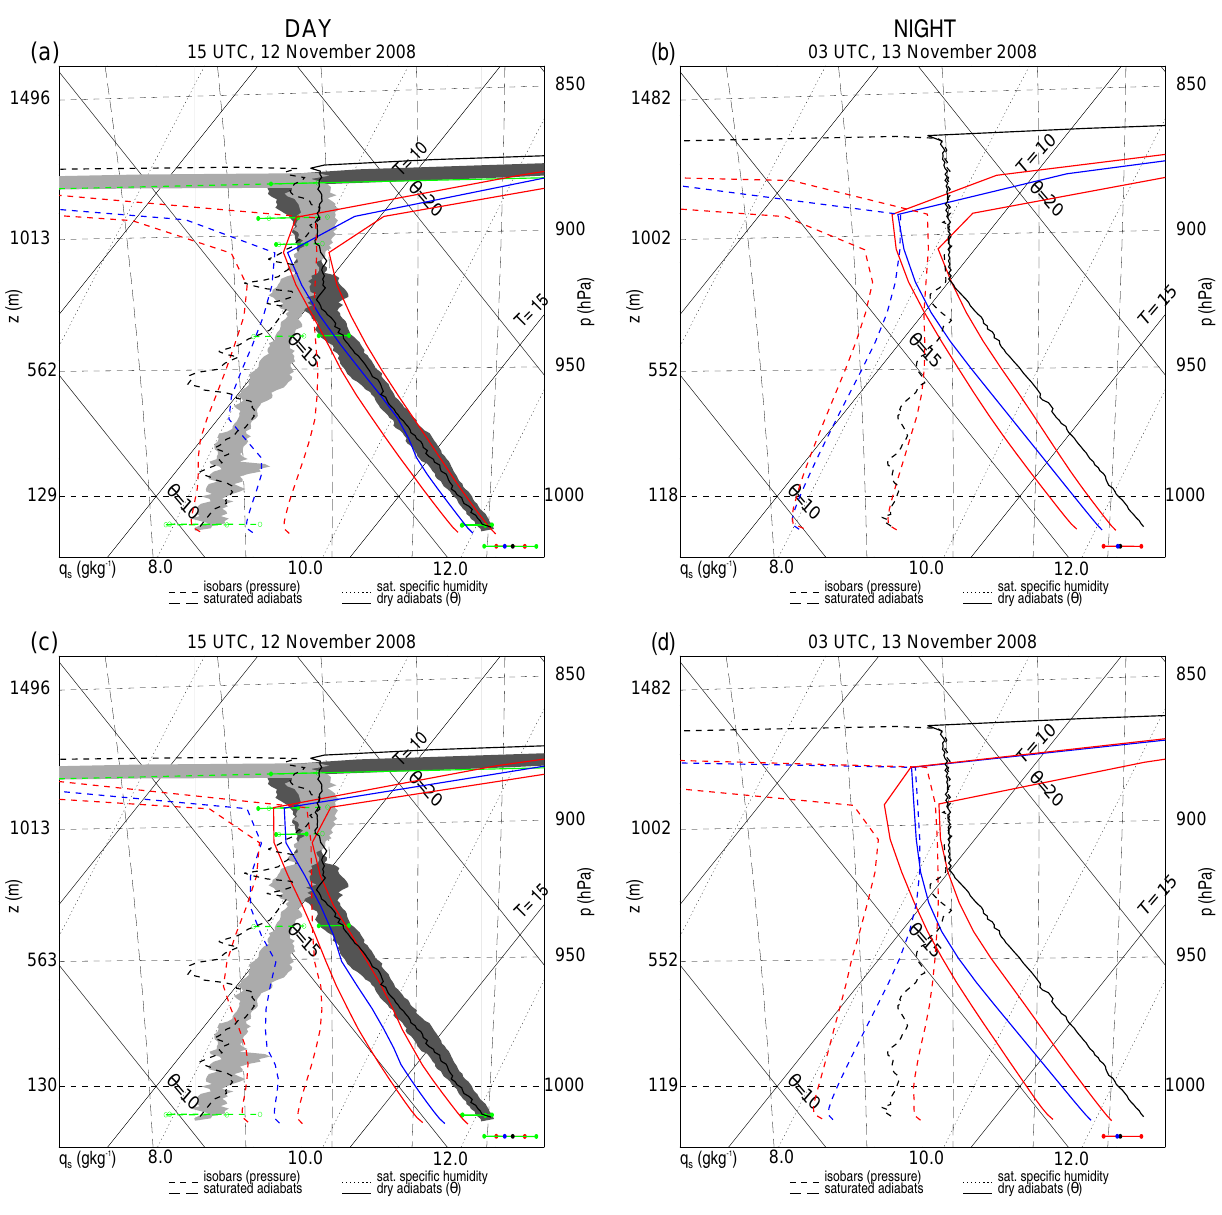
Fig. 4. Radiosonde profiles from the Ron Brown (black) with variability from 5 BAe-146 profiles (grey shading) and 6 straight and level runs (green). Over-plotted is the model profile from the grid-point nearest to the Ron Brown (blue) and the 5th/95th percentiles from a 1 ◦ box surrounding the Ron Brown (red), for the 1km control ( a and b ) and modified microphysics ( c and d ) simulations. The values in the bottom right corner represent the sea-surface temperature.